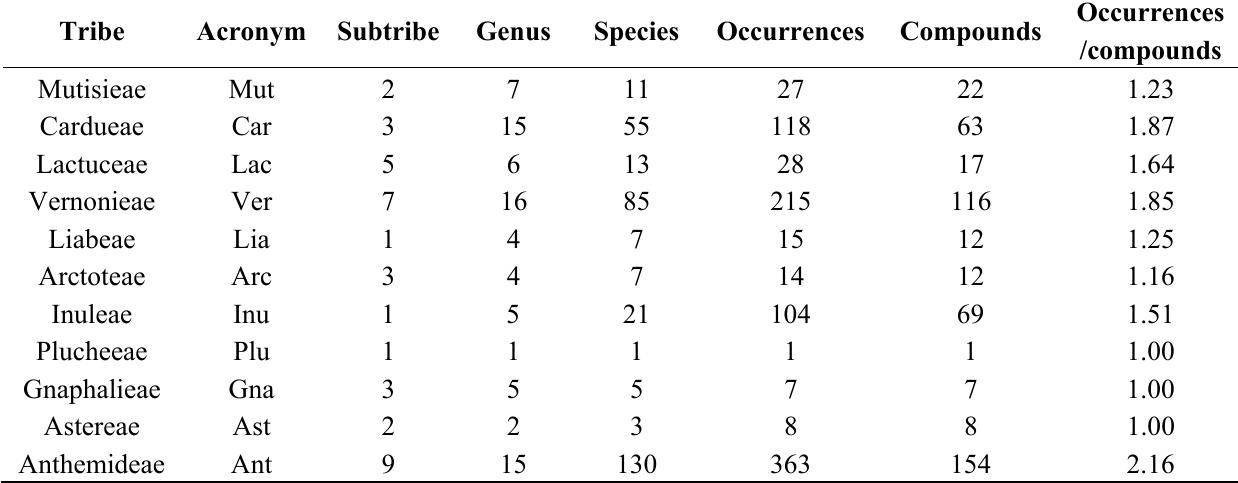
Table 1. Tribes listed following tribe’s subfamily according Bremer [18], respective acronyms, botanical data and chemical occurrences added and used in the